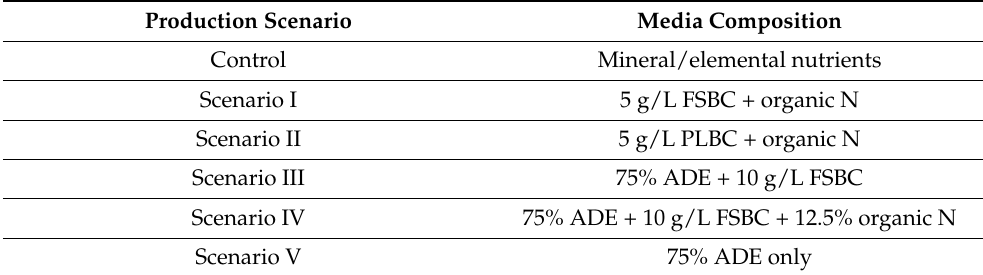
Table 2. Production scenarios used for process design.